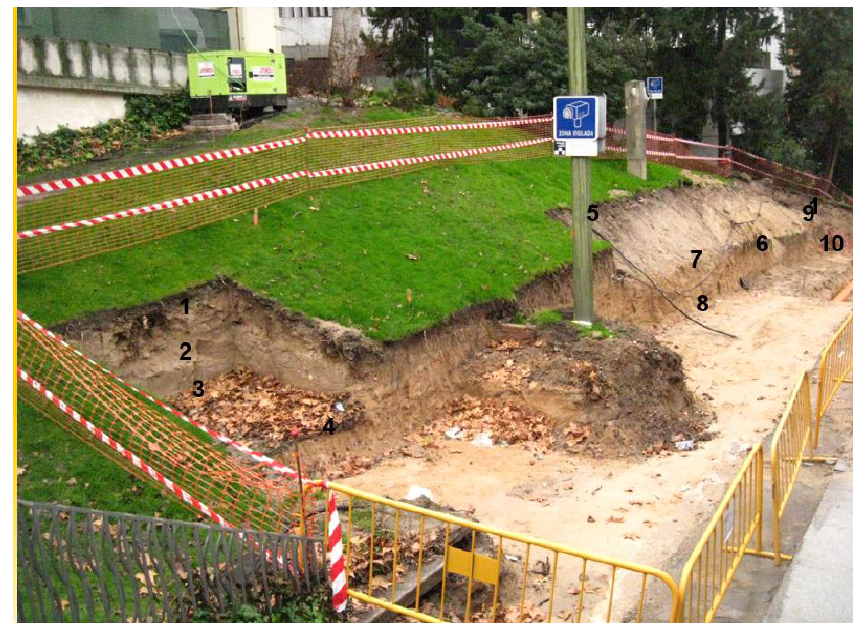
Figure 2. Garden soil profile formed of an artificial mixture of several internal and external artifacts. Samples 1 to 10 correspond to the analyzed soil samples. Sample 2 depicts the bricks, rubble and debris substrate mediums embedded in horizon Bwp; Samples 4, 6, 7 correspond to humic topsoil above mixtures of arkose material, ash and bricks, and probably sludge; Samples 9, 10 are horizons bottom, a sewer ditch filled with sand and other cement